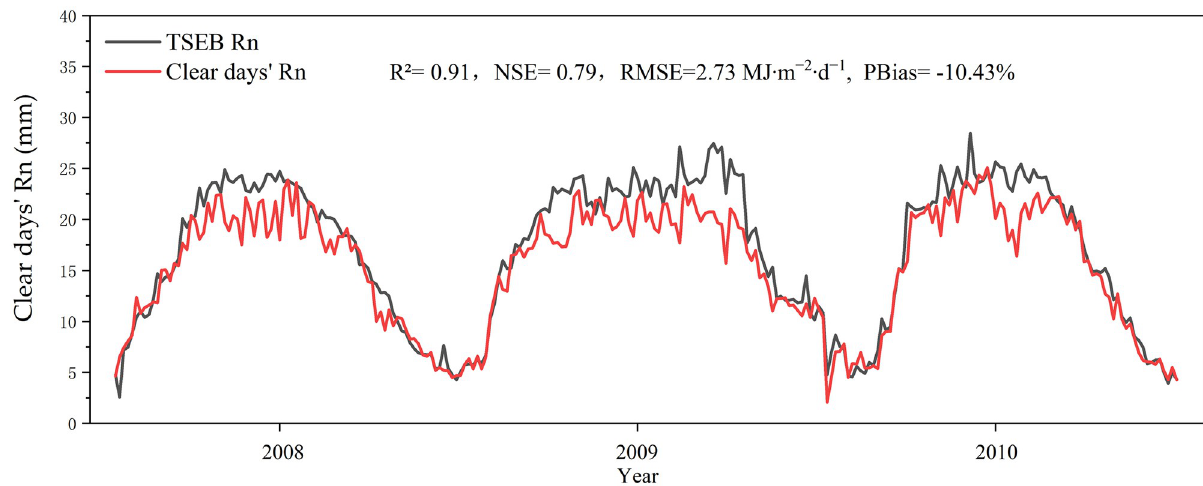
Fig 4. Validation of daily Rn from the TSEB model and daily Rn from AWS observations.